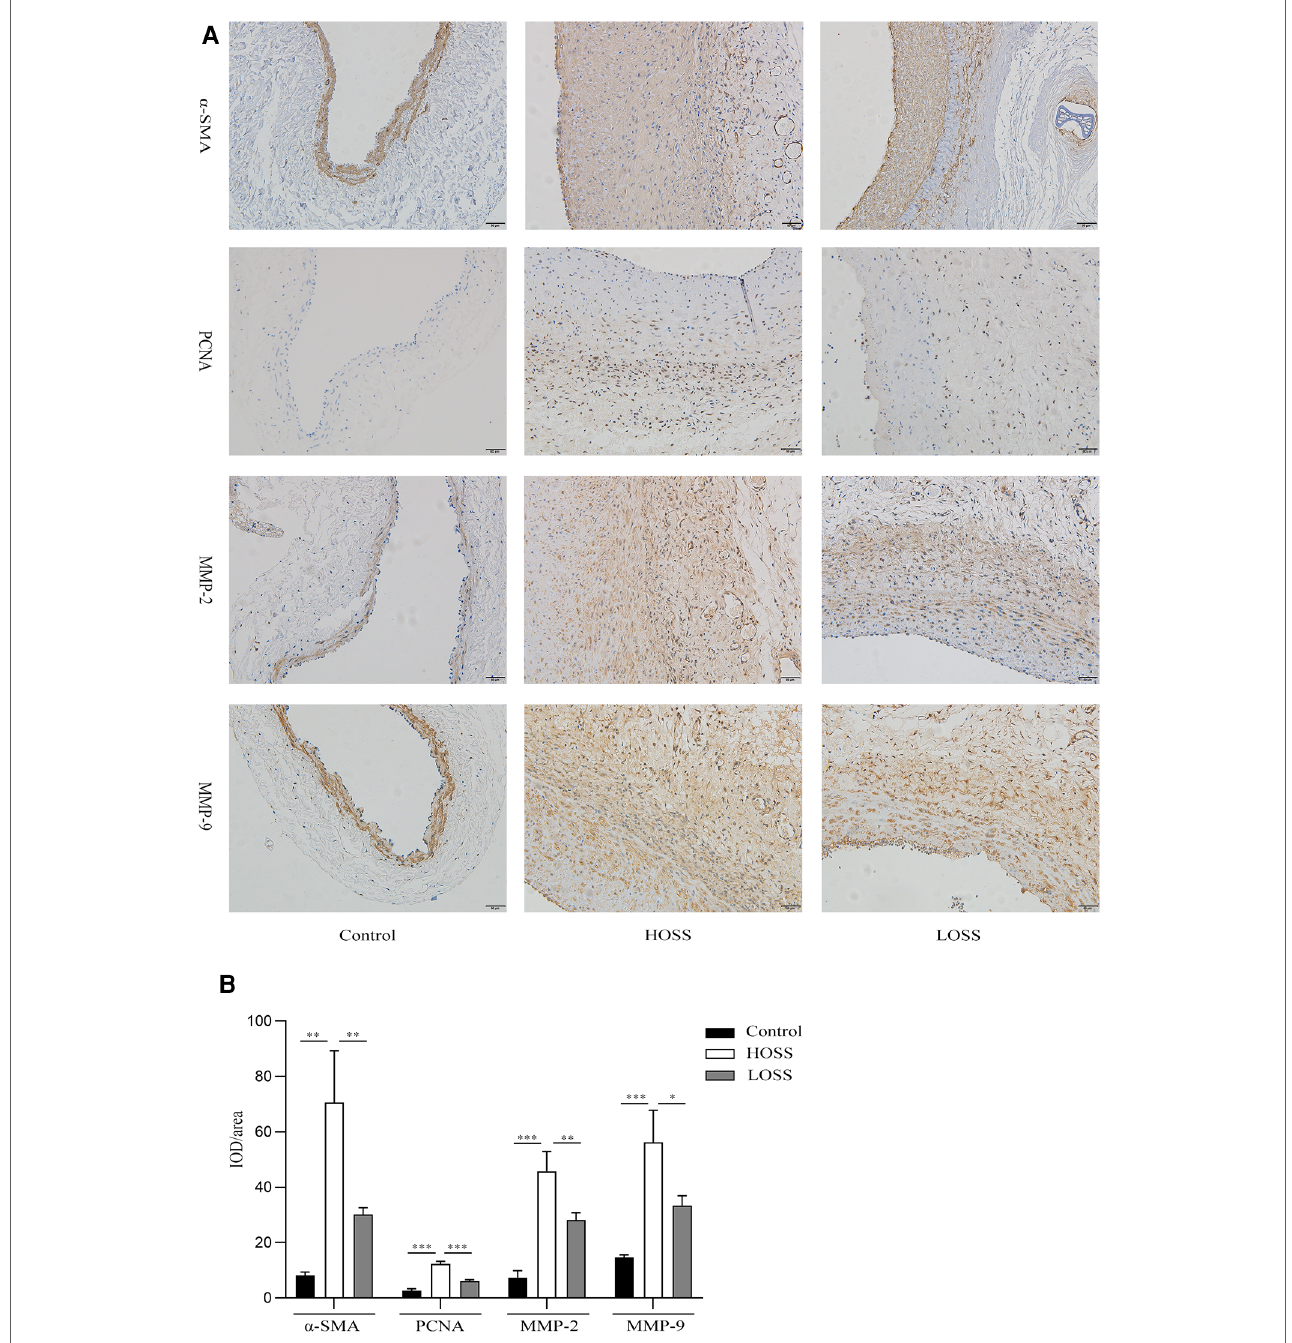
FIGURE 4 Effects of oscillatory shear stress (OSS) on proliferation and migration on vein grafts. ( A ) Immunohistochemical staining was performed to assess the expression of α -SMA, PCNA, MMP-2, and MMP-9 in vascular tissue (magni fi cation,×200). ( B ) OSS promotes the expression of the above proteins, while its reduction slows down the proliferation and migration of vascular smooth muscle cells (VSMCs). Experiments were repeated in triplicate. * P <0.05; ** P <0.01; *** P